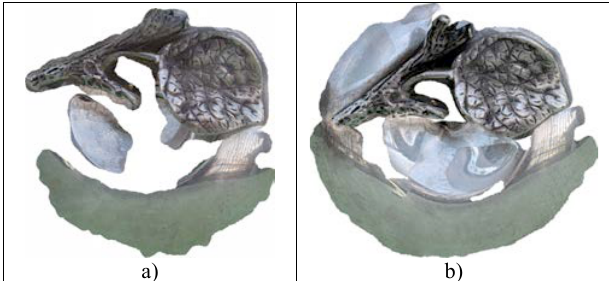
Figure 8. Image matching result from the silver apple images originated with different HDR processing: a) No HDR; b) tone mapped images from HDR